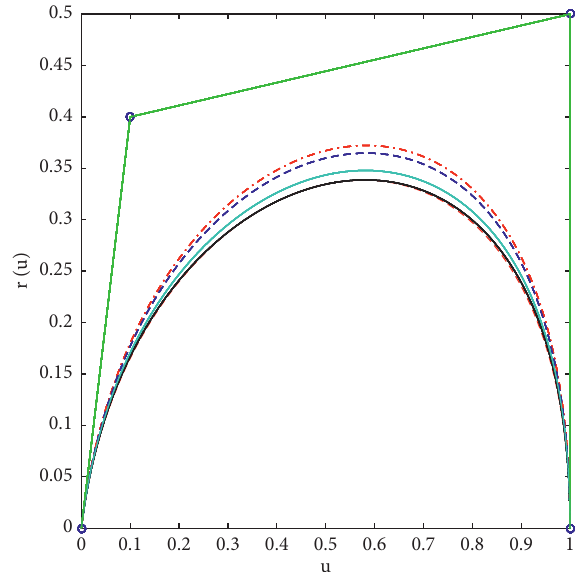
Figure 10: Classic vs. trigonometric B´ezier Curves.